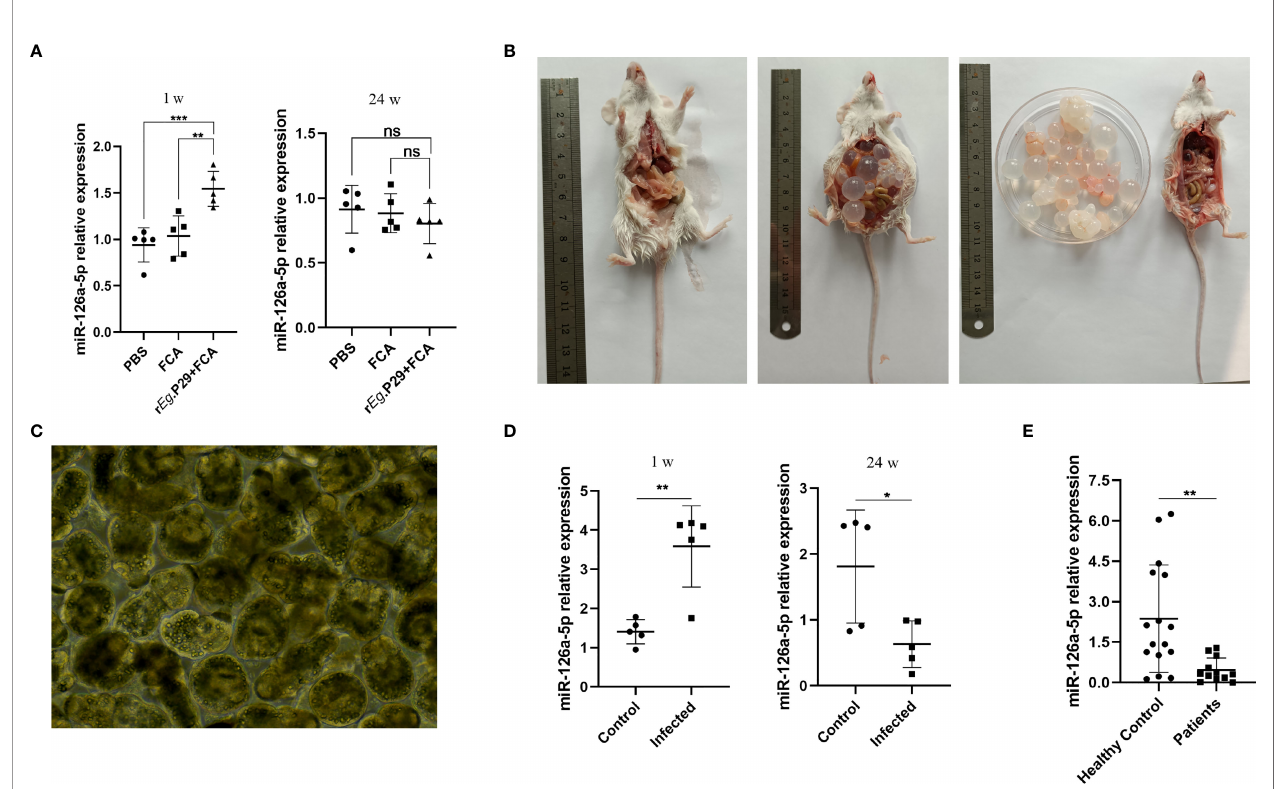
FIGURE 7 | Peripheral blood serum miR-126a-5p was elevated in the early stages of infection with Echinococcus granulosus and declined in the late stages of infection. (A) Examination of miR-126a-5p expression in peripheral blood serum of r E g.P29-immunized mice after 1 and 24 weeks by qRT-PCR. (B) Anatomical view of protoscolex intraperitoneally infected mice and PBS control mice after 24 weeks. (C) Protoscolex isolated from the cyst of a CE patient, magni fi cation 20 × 10. (D) Analysis of peripheral blood serum miR-126a-5p expression in protoscolex intraperitoneally infected mice after 1 and 24 weeks by qRT-PCR. (E) Determination of serum miR-126a-5p expression in the peripheral blood of CE patients ( n = 12) and healthy controls ( n = 16) by qRT-PCR. * P < 0.05, ** P < 0.01,*** P < 0.001; ns, not signi fi